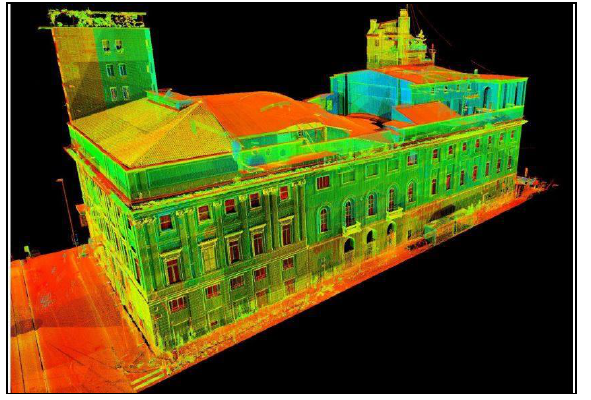
Figure 4. Overall Lyric Theatre point cloud